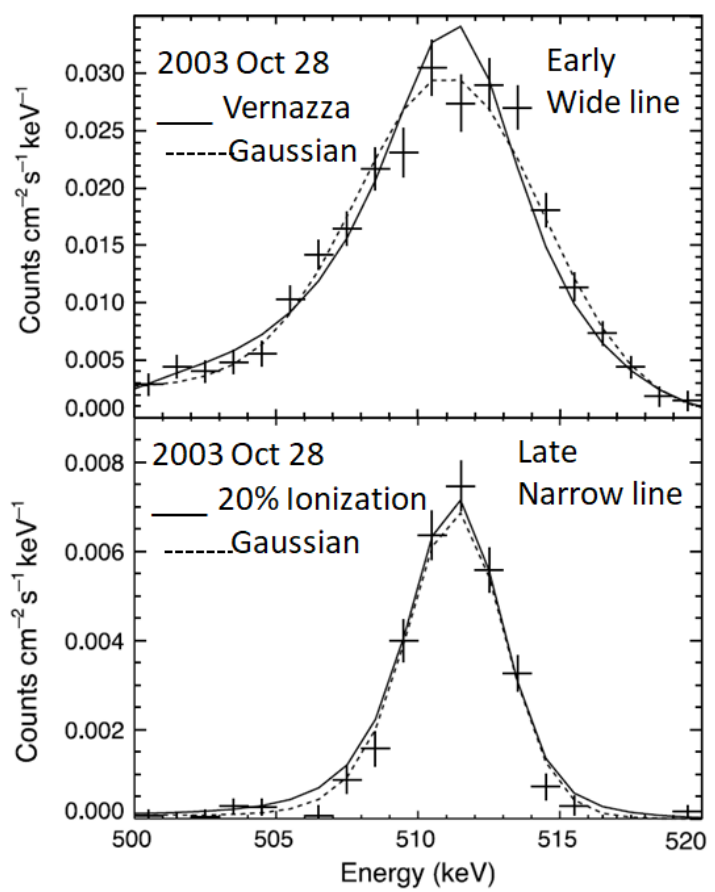
Figure 3. Profiles of the 0.511 MeV annihilation line during the 2003 October 28 event observed by the Reuven Ramaty High Energy Solar Spectroscopic Imager (RHESSI). (Top) During the early phase (first 2 min of observation) the data points are fitted with a Vernazza atmosphere [22] at a temperature of 6000 K and a Gaussian with a width of ~6.7 keV corresponding to a temperature of (3–4) × 10 5 K. (Bottom) During the late phase (last 16 min of observation), the data are fitted with a Gaussian (width ~1 keV) and a 5000-K atmosphere with 20% ionization (adapted from Murphy et al. [5]).